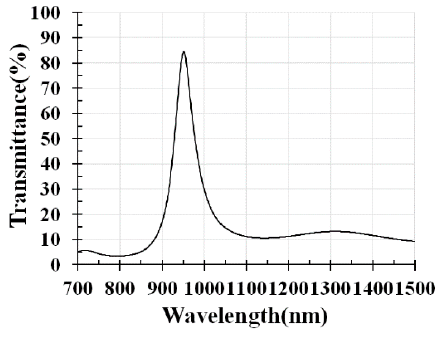
Figure 3. Transmittance spectrum of N i / D 1 M 2 D 3 M 4 / N sub = air/a-Si(67 nm)/Ag(15 nm)/a-Si (212 nm)/ Ag(16 nm)/BK7 glass.